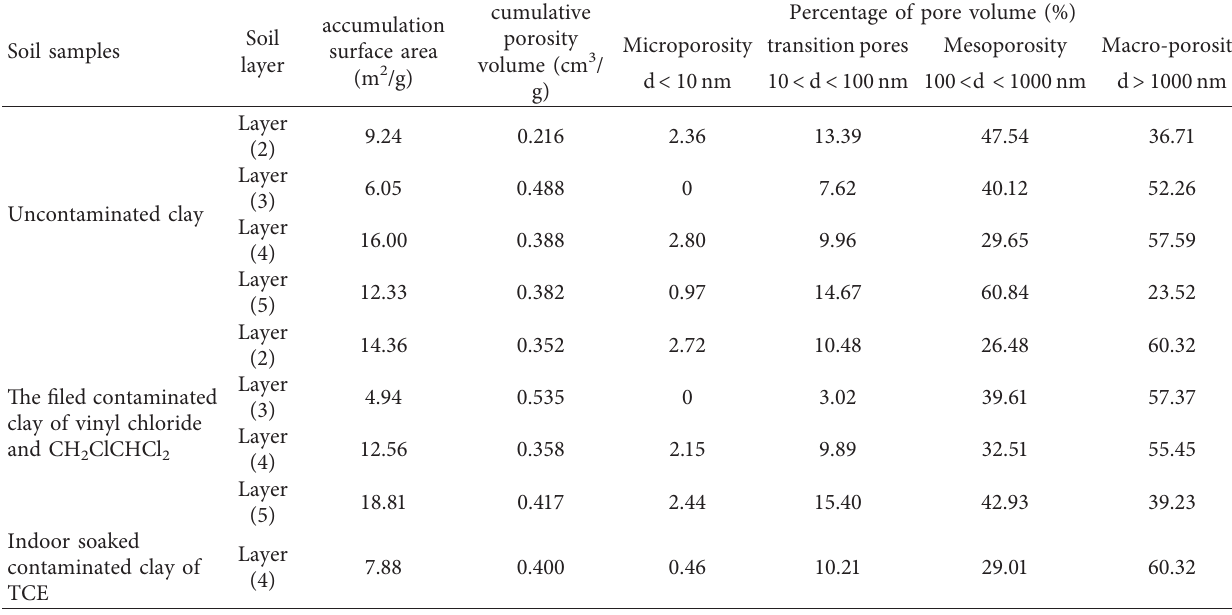
Table 10: The percentage of pore volume and cumulative surface area of contaminated and uncontaminated samples. Soil